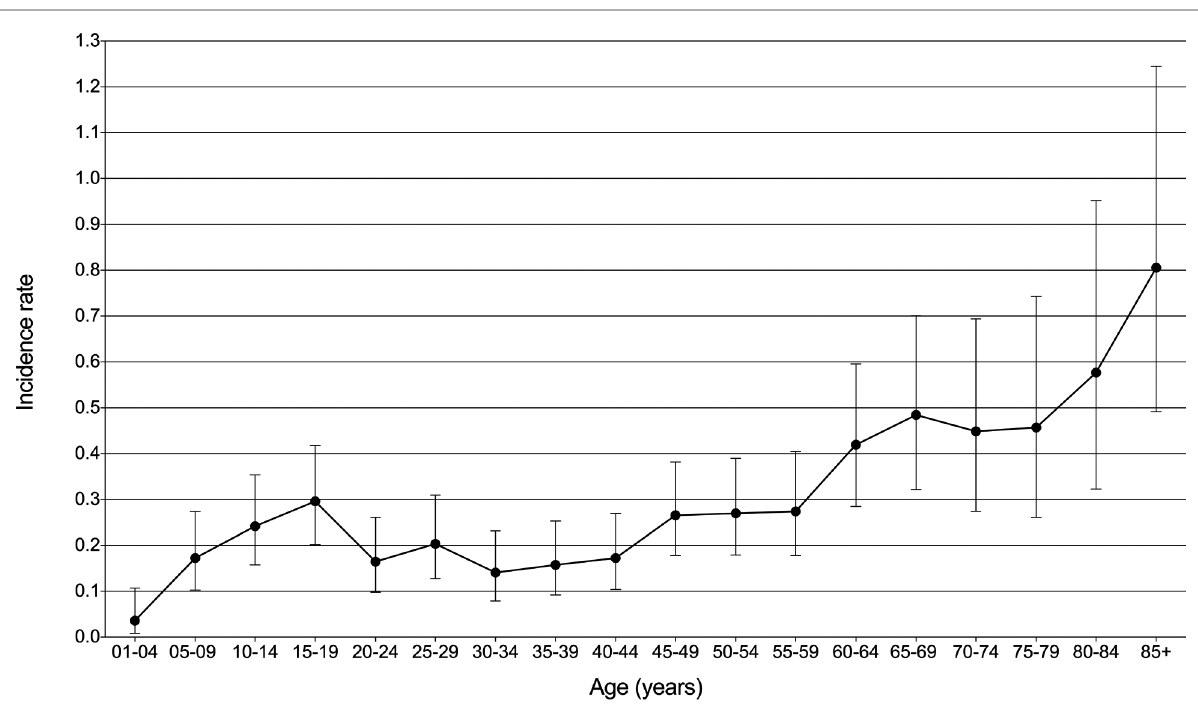
FIGURE 2 Incidence rate with 95% con fi dence interval at each age range in patients with primary malignant pituitary tumor from the SEER research data with nine registries (1975 –